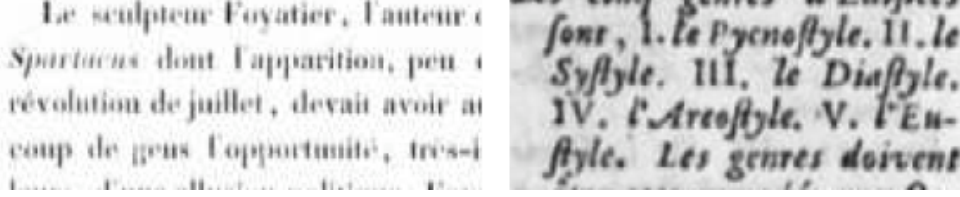
Figure 7. Adaptive blur defect. ( Left ) image with real blur. ( Right ) image with synthetic blur that mimics the real